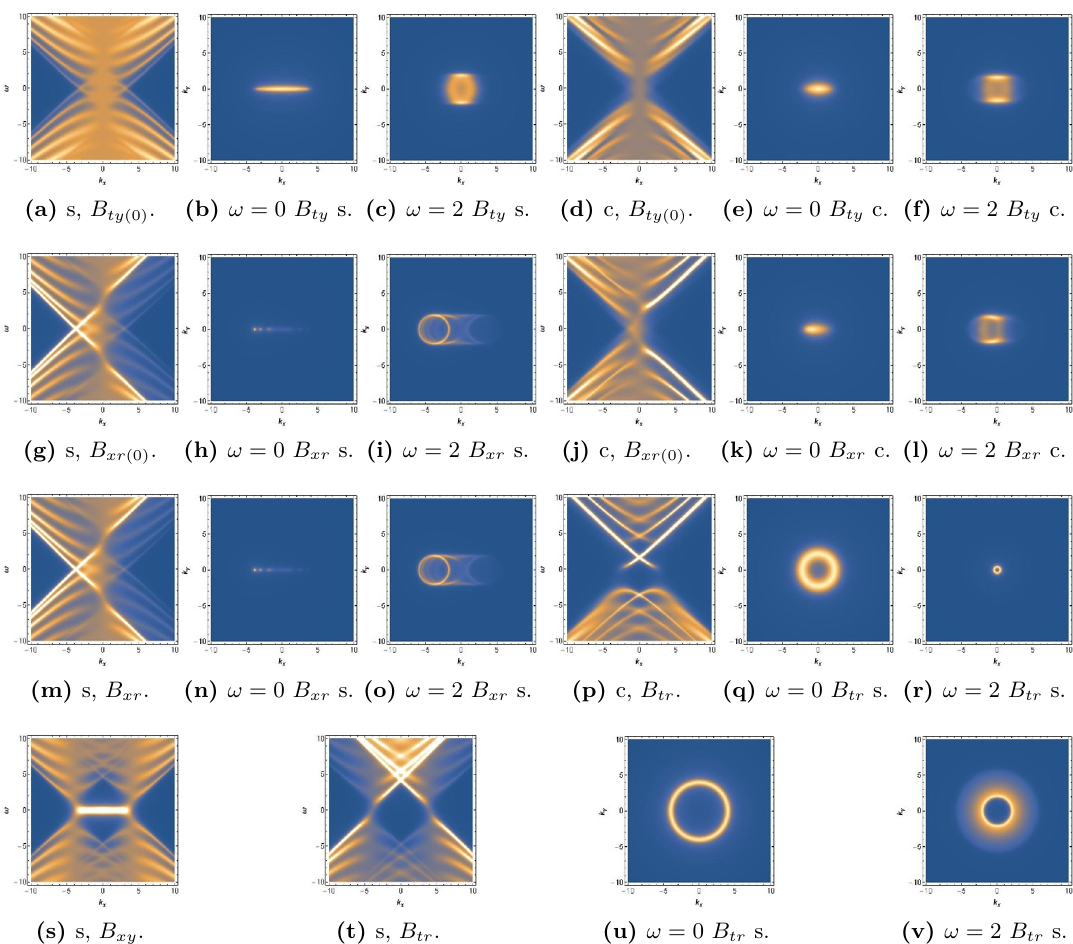
Figure 15. Spectrum of Anti-symmetric tensors. For B xy and B tr , the spectrum is similar to that of the 2-flavor described in the main text due to the rotational symmetry.